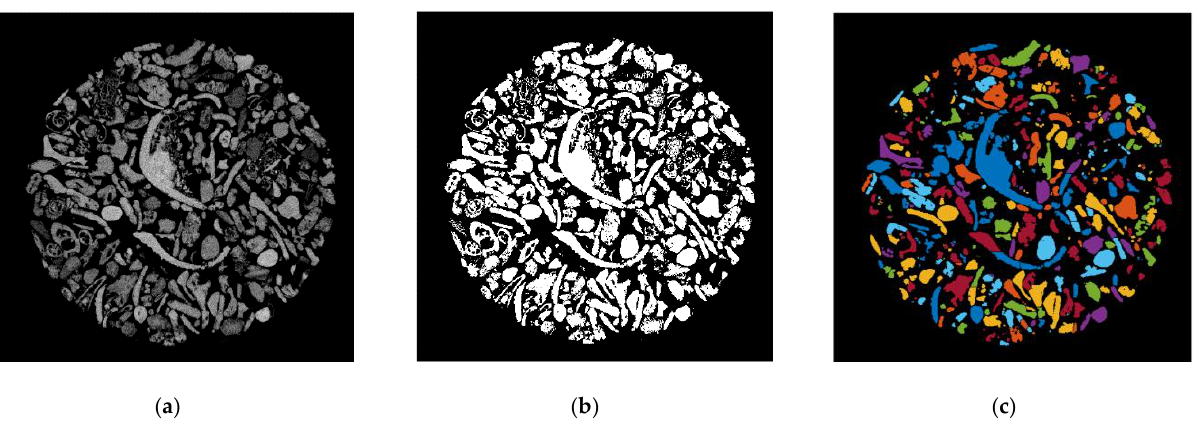
Figure 3. Example of watershed processing of 3D μCT: ( a ) grayscale reconstruction of the µCT slice, ( b ) binary image of the µCT slice, and ( c ) fully segmented image of the µCT slice. ( b ) binary image of the µ CT slice, and ( c ) fully segmented image of the µ CT